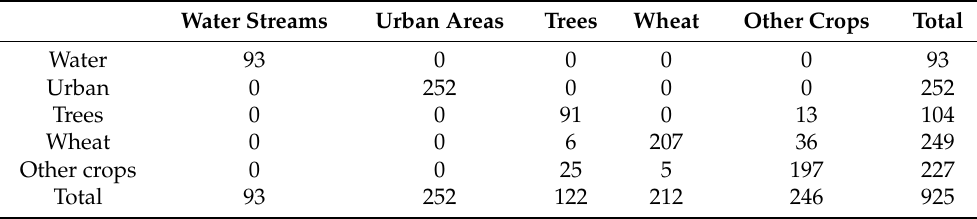
Table 2. The confusion matrix for winter major field crops at a seasonal scale. Water